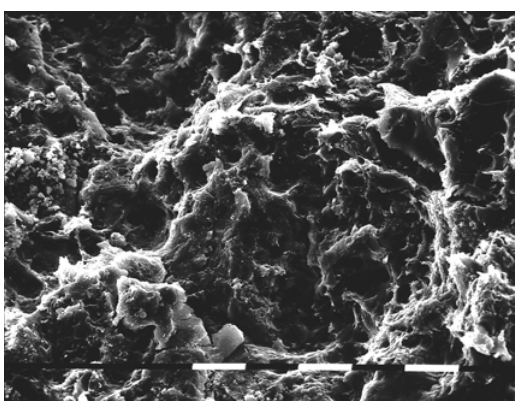
FIGURE 12 . SEM micrograph of peri-implant tissue around TPS implant 3 months after surgery. A bone concavity of mature lamellar peri-implant bone shows microscopic holes corresponding to the microroughness of the removed implant surface. Bar = 10 µm.